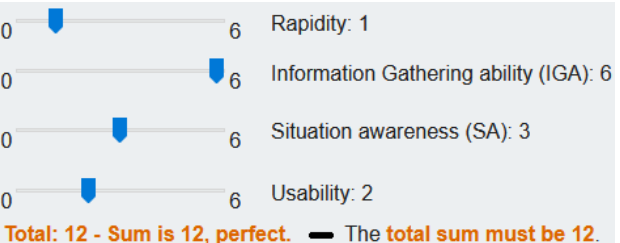
Figure 7. Simple weighting technique with sliders—global quality factors comparison.